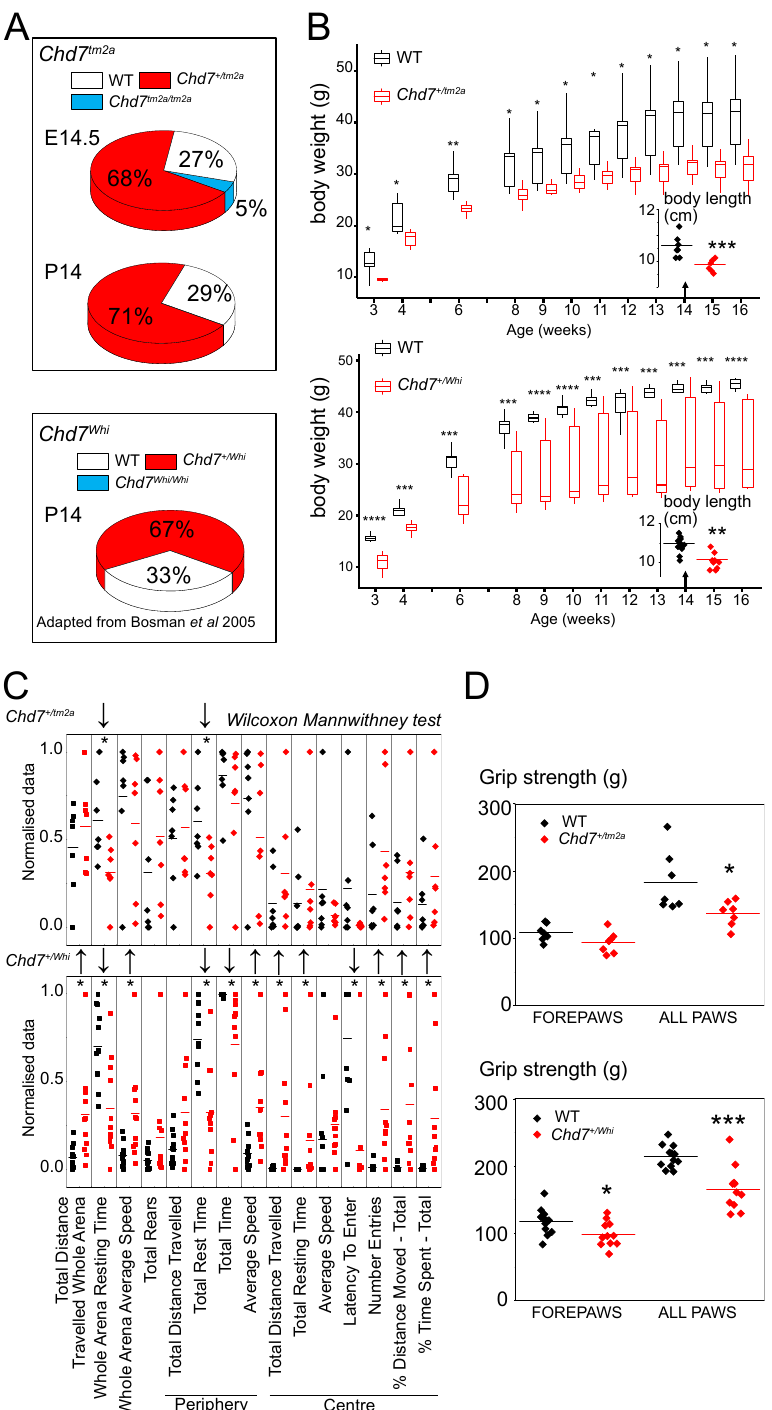
Figure 3. Chd7 +/tm2a and Chd7 +/Whi mice show similar defects in viability, growth, behavioral and grip strength, albeit to different levels. ( A ) Pie chart showing embryonic and after birth viability in Chd7 +/tm2a (this study) and Chd7 +/Whi (adapted from Bosman et al., 2005 [21]). ( B ) Body weight over time and body length at 14 weeks using box plots (SE) and whiskers for outlier boundaries. * p < 0.05, ** p < 0.005, *** p < 0.0005, **** p < 0.00005 using a one-way anova repeated measures. ( C ) Open field arena showing a pronounced increase in locomotor activity in Chd7 +/Whi mice using a Wilcoxon mann-whitney test. ( D ) Mean and individual points showing severe ( Chd7 +/Whi mice) and mild ( Chd7 +/tm2a ) decrease in grip